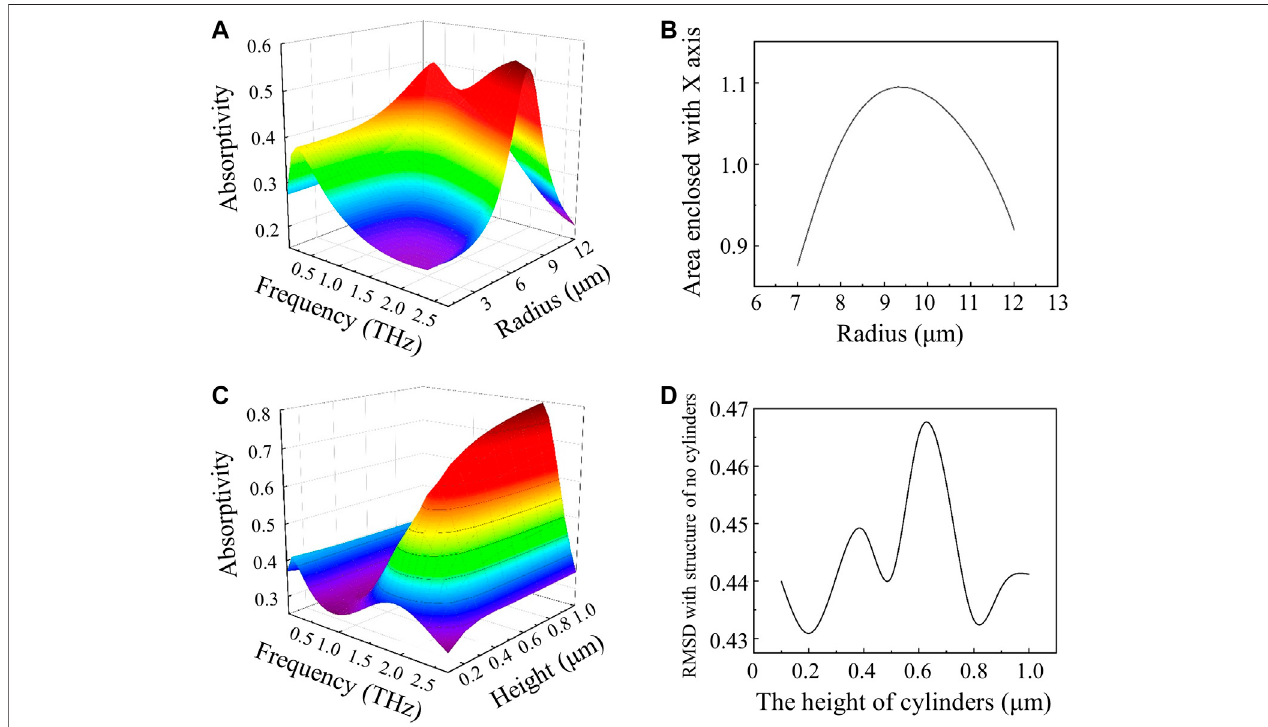
FIGURE 5 | The absorptivity of material with parameters of cylinders changing in 0.1 – 2.7 THz. (A) radius; (C) height; (B) the area of absorptivity curves enclosed with X axis when radius of cylinders changing; (D) the root-mean-square deviation of absorptivity between structure with and without cylinders in infrared band when there are changes in the height of